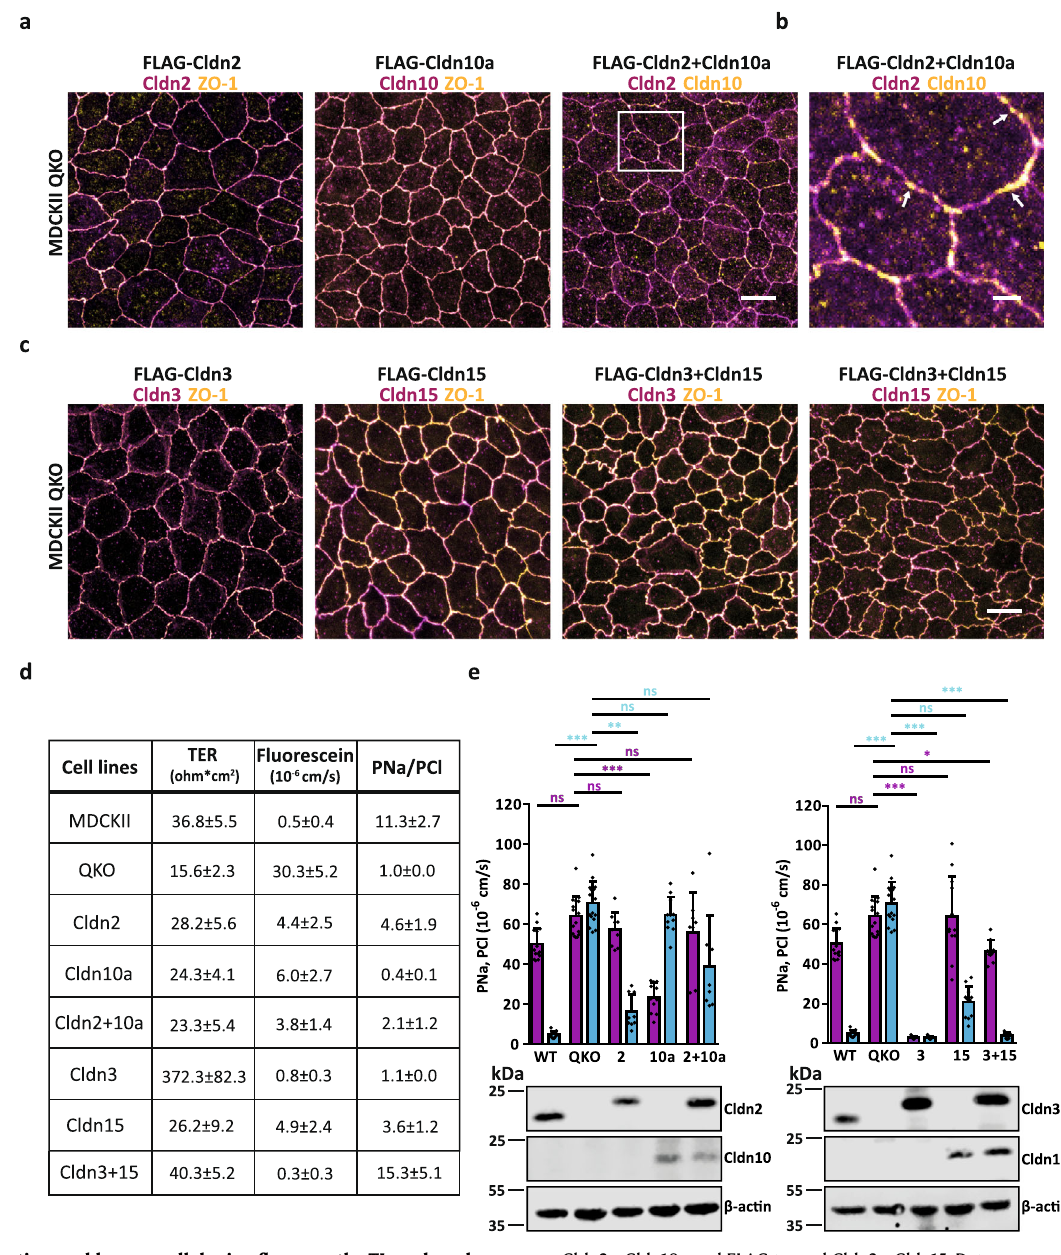
Cldn2+Cldn10a and FLAG-tagged Cldn3+Cldn15. Data represent the mean±SD from 3 to 5 independent experiments. Single data points are shown in Supple- mentary Fig. 12. e Absolute permeability for sodium (PNa; magenta bars) and chloride (PCl; cyan bars) of MDCKII, MDCKII QKO and MDCKII QKO sT FLAG- tagged Cldn2, Cldn3, Cldn10a, Cldn15, and MDCKII QKO sT FLAG-tagged Cldn2+ Cldn10a and FLAG-tagged Cldn3+Cldn15. Data represent the mean±SD. For the electrophysiological measurements every n represents one transwell fi lter; n (MDCKII)=14; n (MDCKII QKO)=14; n (FLAG-Cldn2)=9; n (FLAG-Cldn10a)=11; n (FLAG-Cldn2+FLAG-Cldn10a)=8; n (FLAG-Cldn3)=9; n (FLAG-Cldn15)=12; n (FLAG-Cldn3+FLAG-Cldn15)=9; from 3 – 5 independent experiments; one-way ANOVA with Kruskal – Wallis test; *** P ≤ 0.001, ** P ≤ 0.01, ns (not signi fi cant). The total claudin expression level was determined by immunoblotting for Cldn2, Cldn3, Cldn10, and Cldn15 (20 – 25kDa). β -actin (40kDa) served as control. All representative images derive from 3 independent experiments. Scale bars, 10 μ m ( a , c ), 2 μ m ( b ). Source data are provided as a Source data fi le.